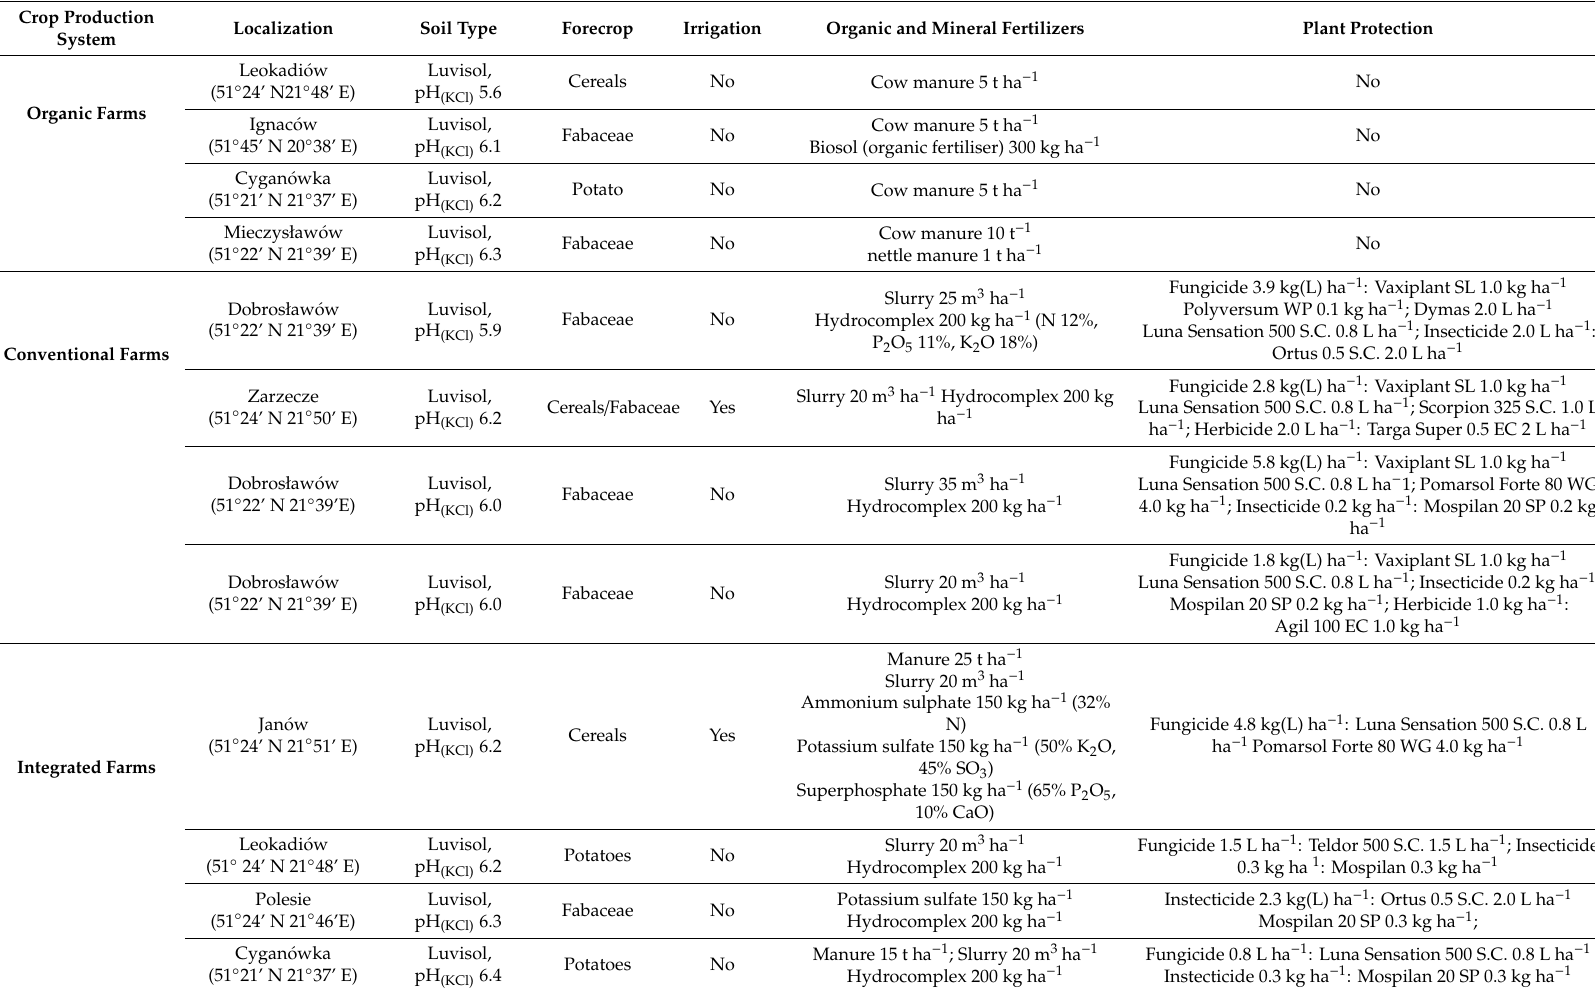
Table 1. Major agricultural practices in di ff erent crop production systems in experimental